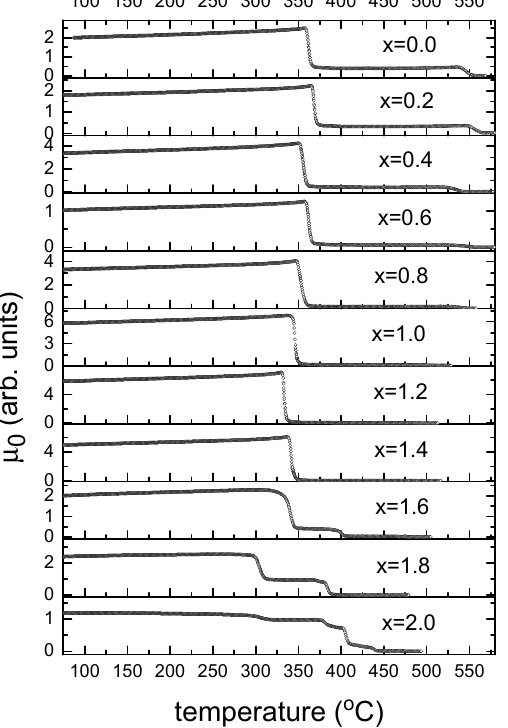
Figure 1. Temperature dependences of the initial permeability measured in an alternating magnetic field of 1 Oe and a frequency of 5 kHz. The numbers in the figures are the concentration of Cu 2+ ions in Ni 2-x Cu x -Y samples. The high-temperature section of the dependence µ 0 ( T ) of the Ni 2 -Y ( x = 0.0) hexaferrite plotted on an enlarged scale is shown in Figure 2. The vertical arrows mark the minima on the derivative d ( µ 0 ( T ))/ dT , which we took as estimates for the Curie temperatures of the corresponding crystallographic phases. The temperature T C-S corresponds to the Cu- rie temperature of the spinel phase Ni x Cu y Fe 3-x-y O 4 , T C-M corresponds to the hexagonal M- phase, and T C-Y1 is the temperature of the appearance of magnetic ordering of the EMP type of Ni 2-x Cu x -Y hexaferrites. The feature marked by T C-Y2 is present on the µ 0 ( T ) ther- mograms up to compositions with x = 1.2 and is not observed at higher concentrations of Cu 2+ ions.